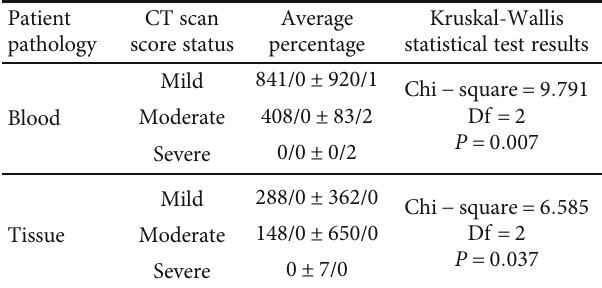
Figure 1: Sections show polypoid lesion covered by respiratory epithelium. Table 2: Comparison of the average percentage of blood and tissue eosinophils in patients according to CT scan score.